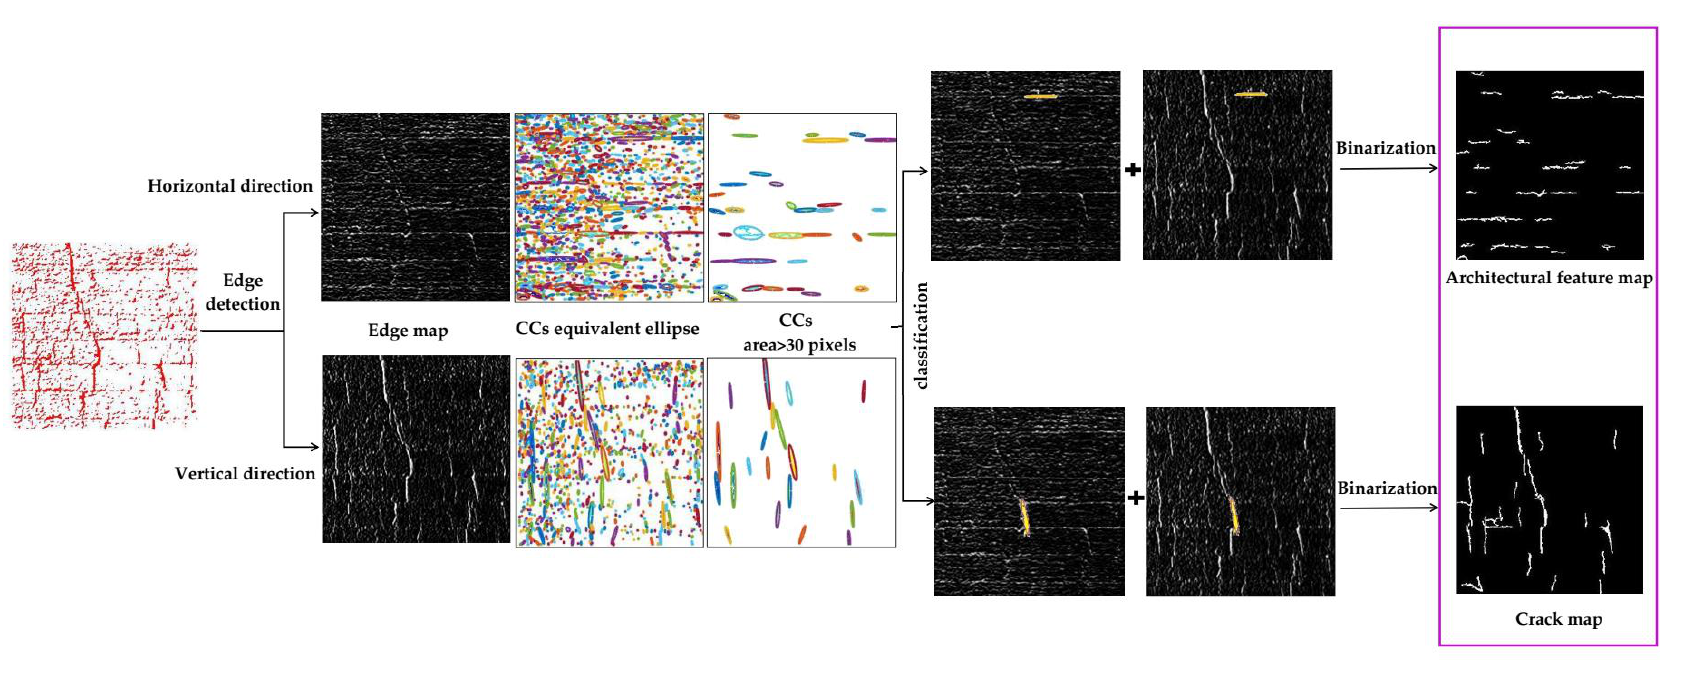
Figure 2. Scheme of the developed methodology.